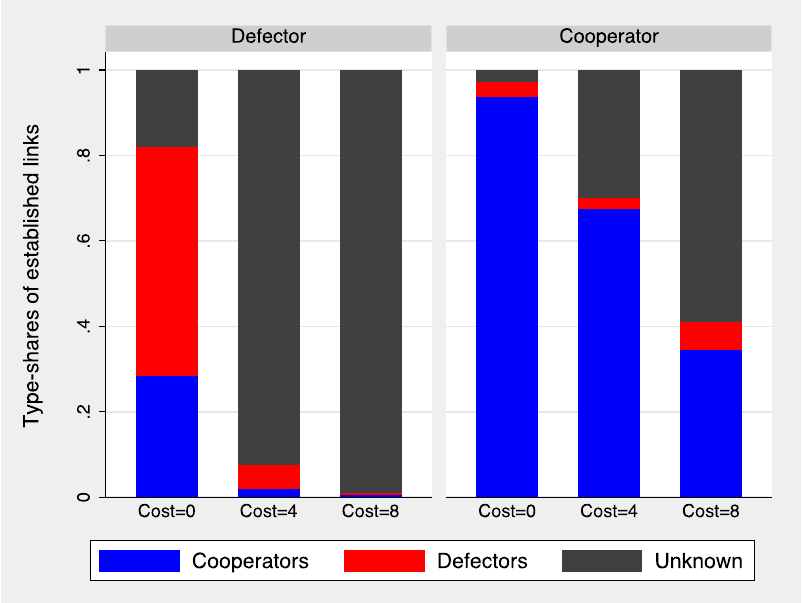
Figure 8. Proportion of established links with defectors, cooperators, and unknown partners according to players’ current type and as a function of the cost c .